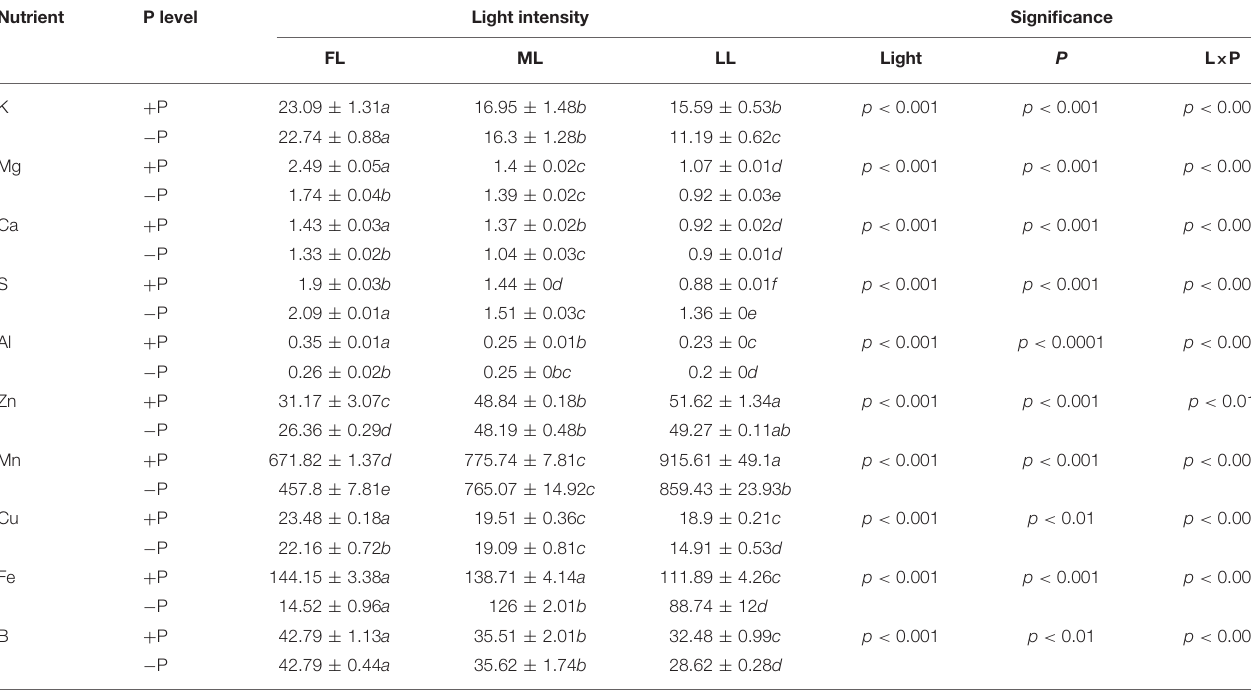
TABLE 2 | Concentrations of macronutrients (K, Mg, Ca, S, and Al, mg g − 1 ) and micronutrients (Zn, Mn, Cu, Fe, B, mg kg − 1 ) in young shoots under different light intensities and P levels.